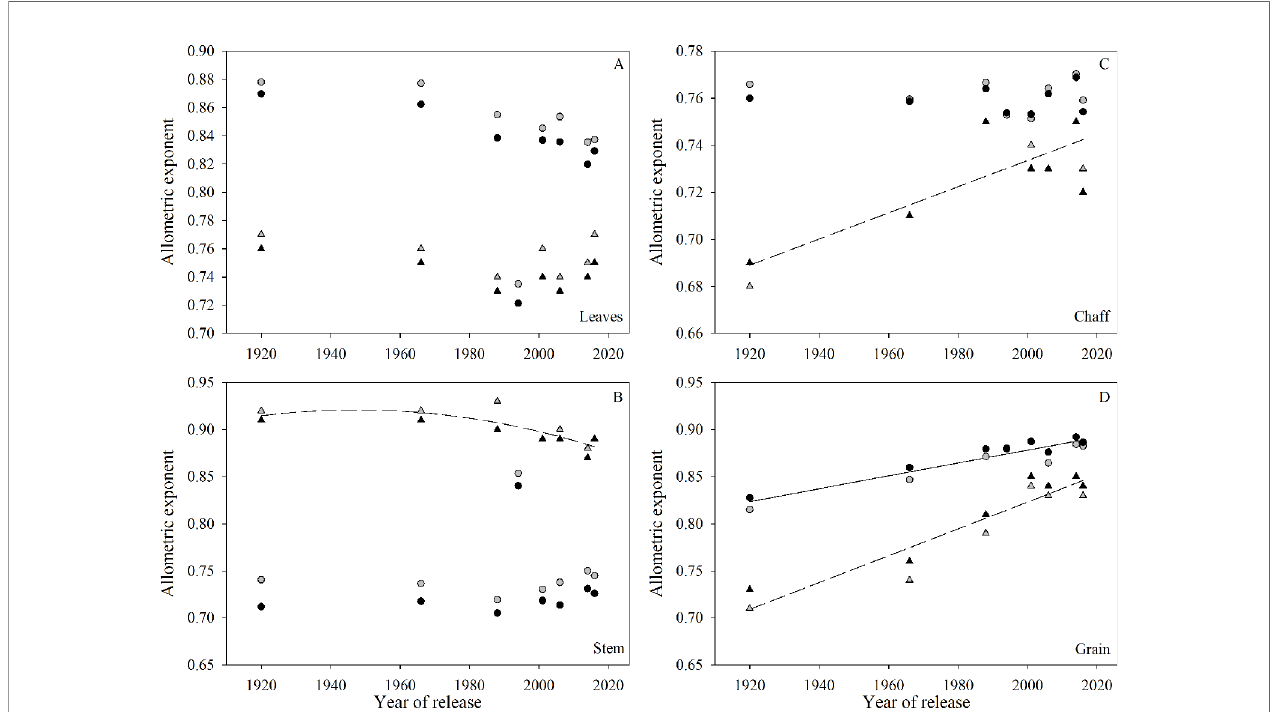
FIGURE 5 | Relationship between allometric exponent (slope of log of plant organ biomass versus log of shoot biomass) and year of release for each plant organ: (A) leaves, (B) stem, (C) chaff, and (D) grain. Symbols ( ▲ ) and dashed lines refer to the 2016-2017 growing season, symbols ( (cid:129) ) and solid lines refer to 2017- 2018 growing season. Black symbols are the control treatment and grey symbols are the in-furrow fertilizer treatment. Only signi fi cant (P < 0.05) regressions are